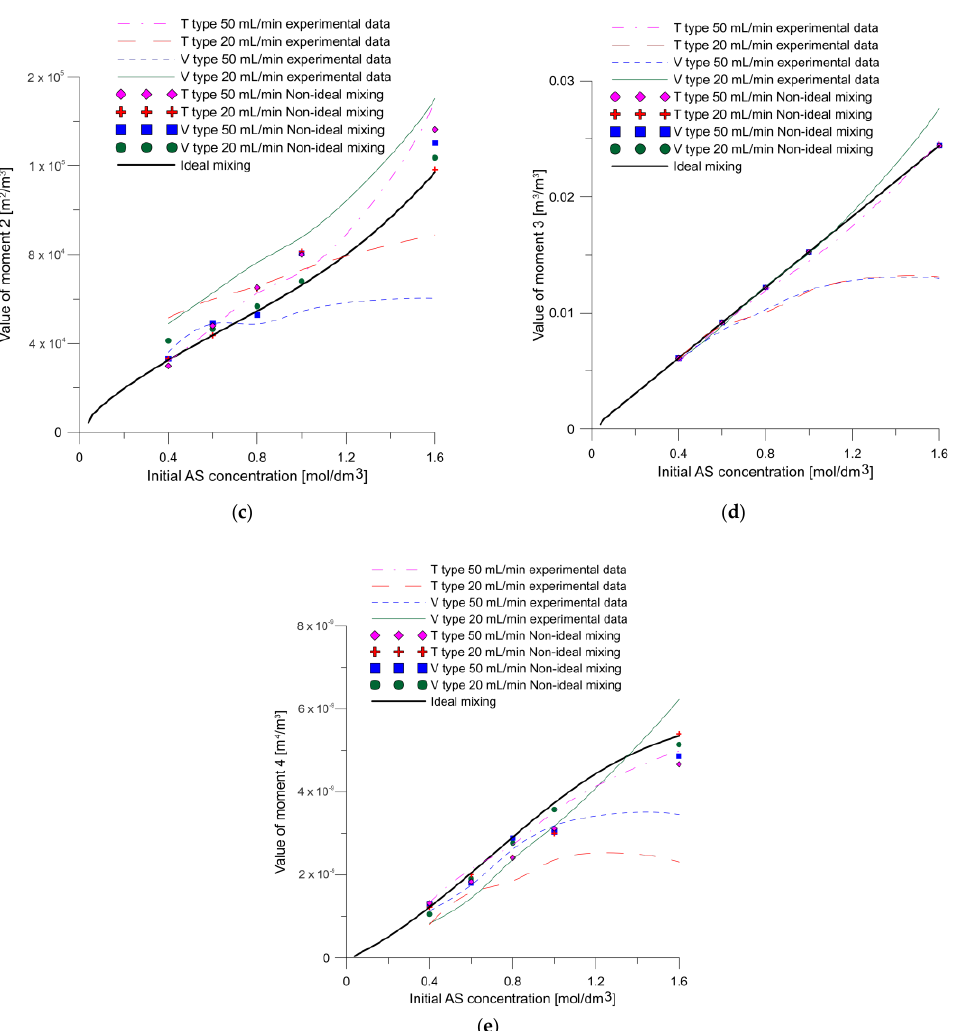
Figure 15. Particle moments in function of initial AS concentration for experimental results and calculated in ideal and nonideal mixing condition ( a ) moment 0, ( b ) moment 1, ( c ) moment 2, ( d ) moment 3, ( e ) moment 4.